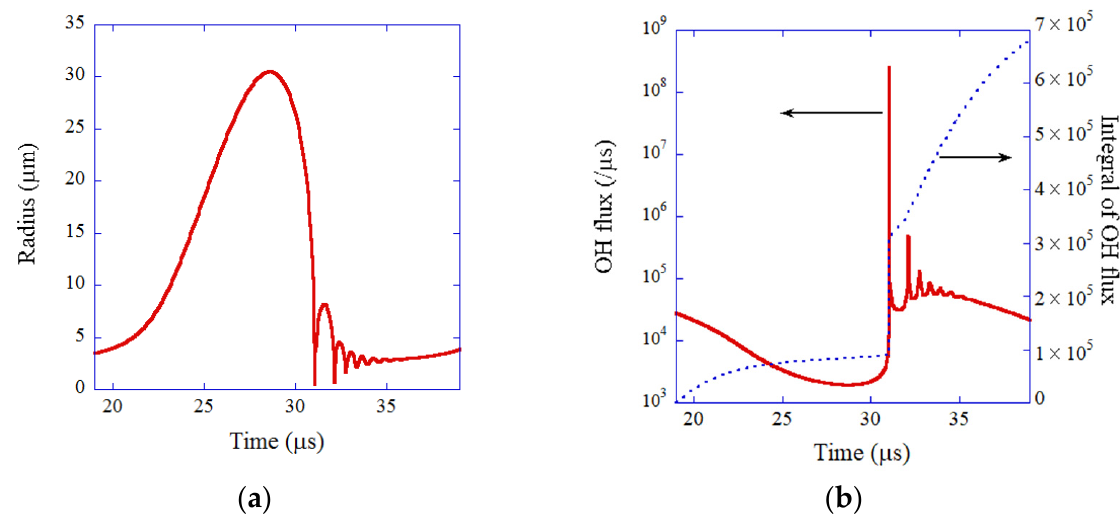
Figure 3. The results of numerical simulation of the ODE model for single-bubble sonochemistry for one acoustic cycle ( a ) The bubble radius. ( b ) OH flux and its time integral. Reprinted with permission from Ref. [74]. Copyright 2005, AIP Publishing.